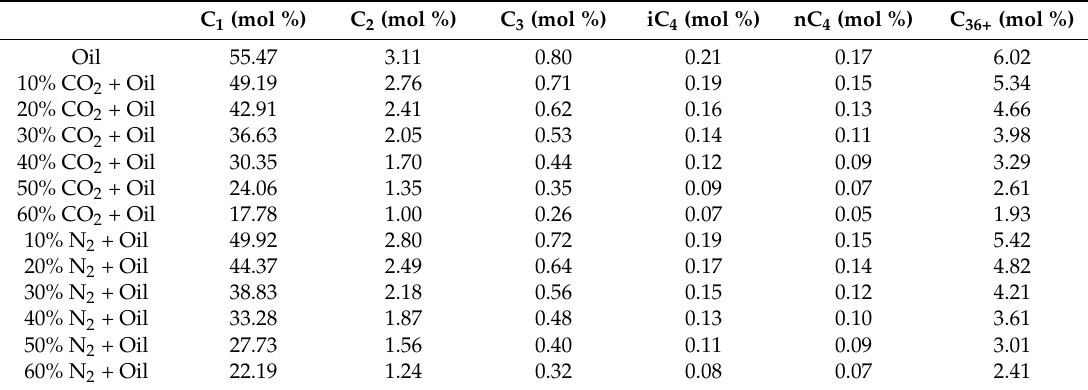
Table 6. Composition change of crude oil with different CO 2 and N 2 injection volumes in a buried-hill